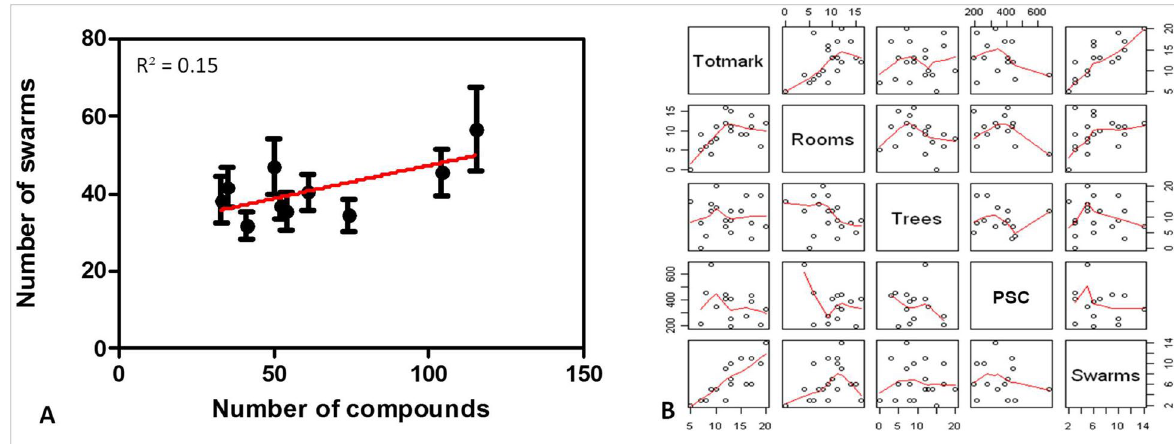
Figure 3. Correlation analysis between swarm abundance and the number of compounds ( A ) and the number of visual markers ( B ). PSC pyrethrum spray catch, Totmark total number of markers.